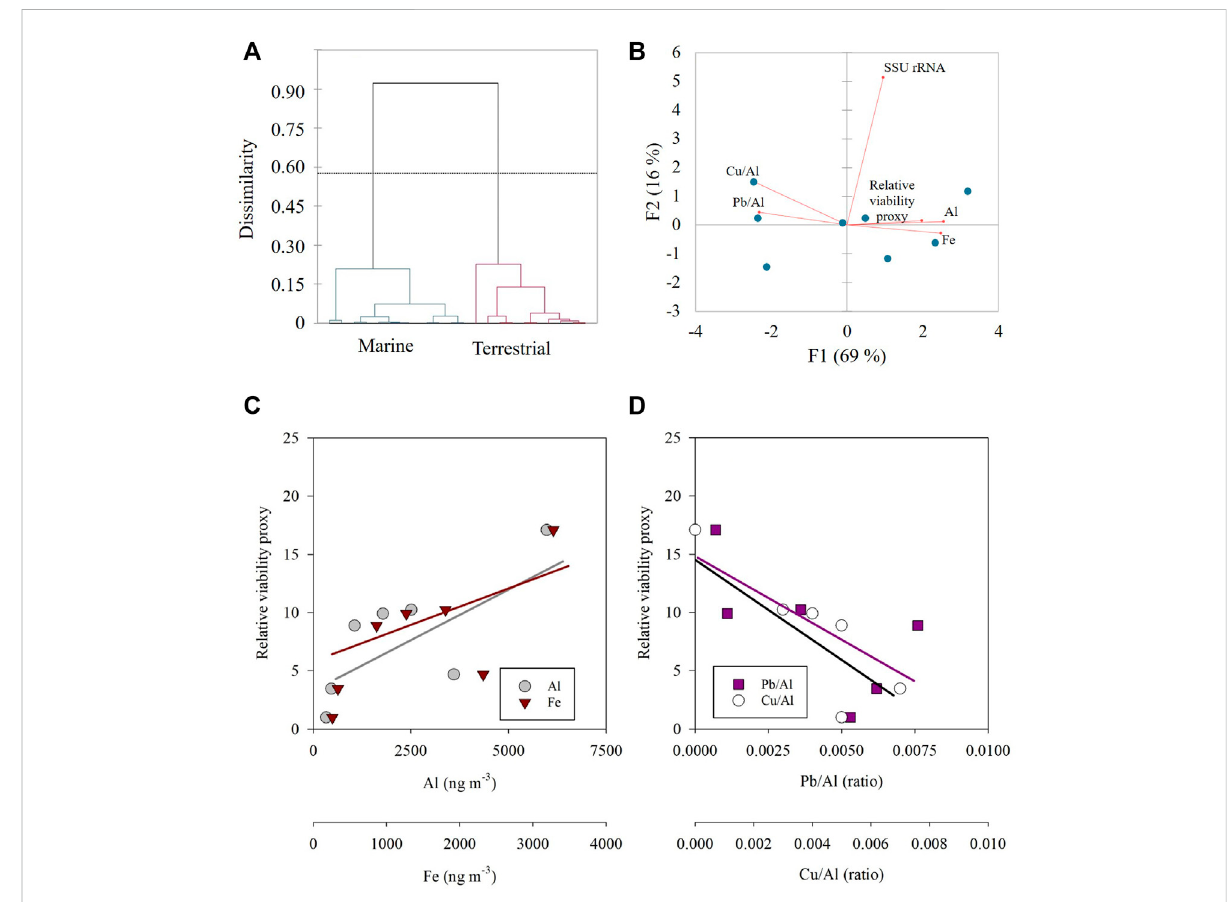
FIGURE 4 (A) An agglomerative hierarchical clustering (AHC) dendrogram showing the dissimilarities (Euclidean distance) between aerosols with marine (green) and terrestrial (red) origin; (B) Principle component analysis (PCA) of the marine-origin trajectories; (C,D) The relationship between the relative potentially viable airborne prokaryotes and Al (grey), Fe (dark red), Pb/Al (dark pink) and Cu/Al (white) in marine-origin aerosols [corresponds to panel (B)